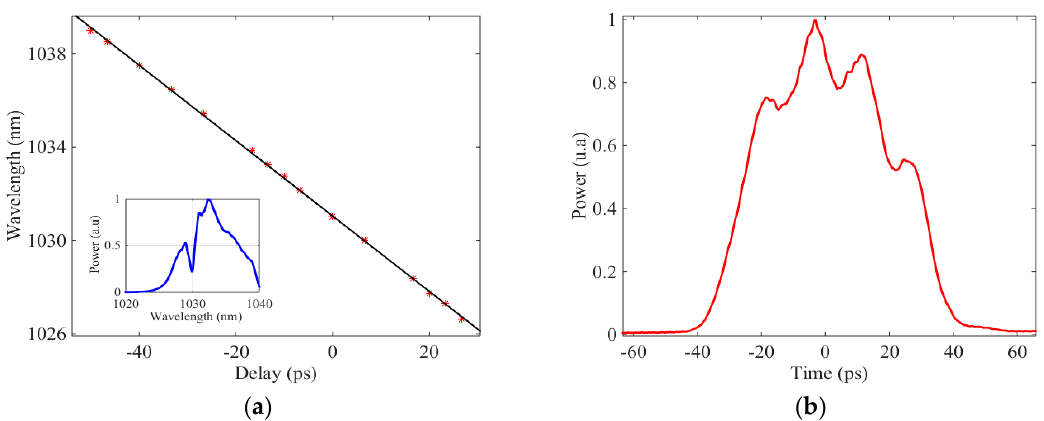
Figure 5. ( a ) Measurement of the chirp rate by spectral interferometry and its linear fit leading to α = 6.2 ps/nm. The inset is an example of the interference pattern. ( b ) Temporal shape of the pump pulse.